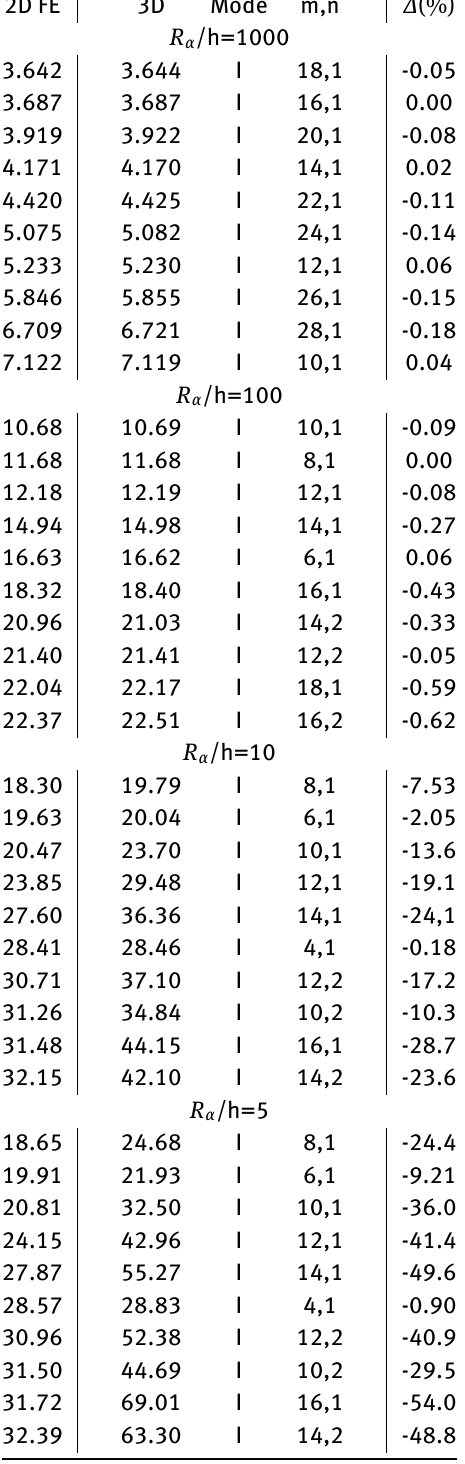
Table 19: Twelfth benchmark, simply supported sandwich cylinder embedding isotropic skins and PVC core with thickness